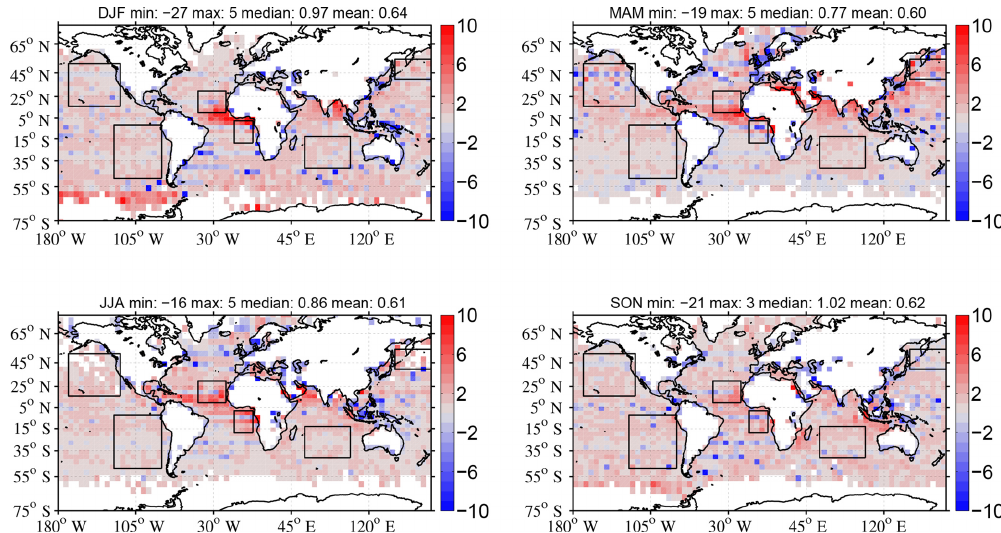
Figure 8. Seasonal maps showing the differences in SW TOA DARE non-cloudy computed using the average-then-retrieve (A-R) and the retrieve-then-average (R-A) strategies. Positive values (in red) show regions where the A-R DARE calculations are larger, whereas negative values (in blue) show regions where the R-A DARE calculations are larger. The squares show different regions defined in Table 5. The title of each map shows the global minimum, maximum, median and mean